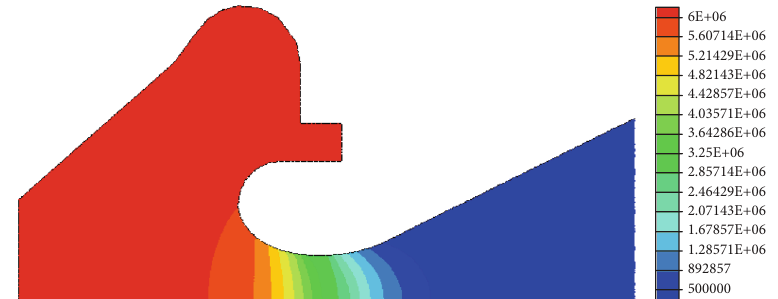
Figure 6: Pressure distribution about the steady fi eld of SRM,